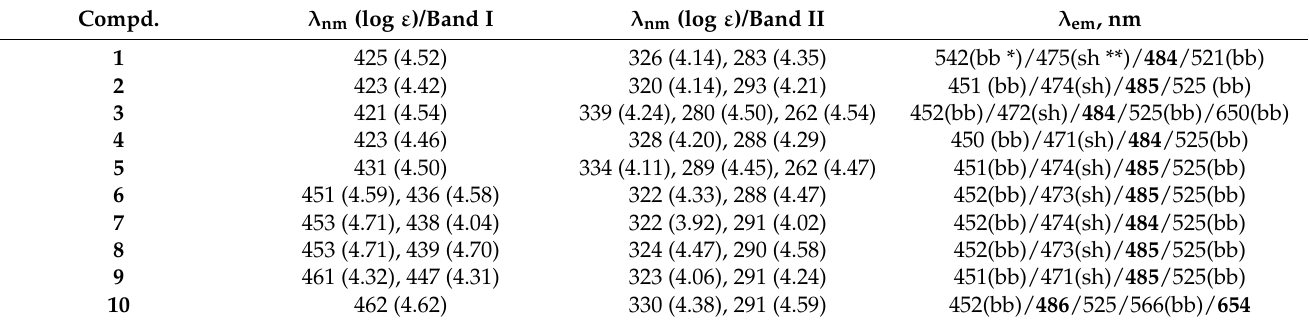
Table 4. UV-Vis absorption and emission bands of azulene-containing